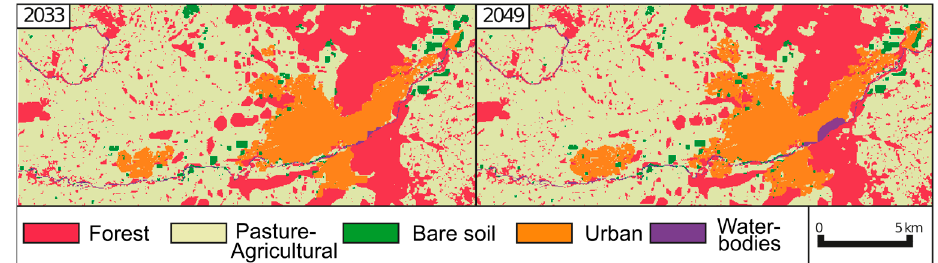
Figure 5. Simulated scenarios in 2033 and 2049. Source: Authors’ compilation.